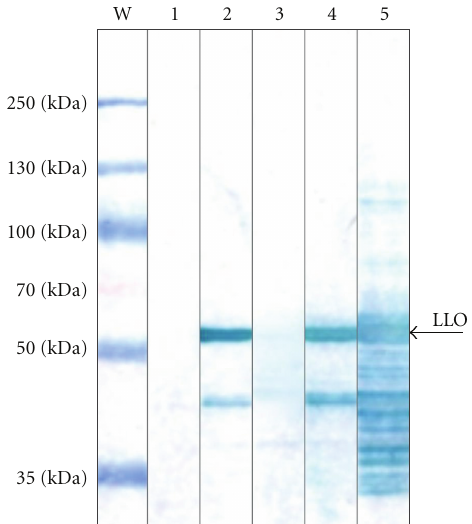
Figure 2: Western blot analysis of B. subtilis supernatants. Results of Western blot analysis of Bacillus subtilis supernatants with anti-LLO polyclonal antibody. 1: control wild-type strain MB4 supernatant , 2: BR1/S + IPTG, 3: BR1/S without IPTG, 4: BR1/89 + IPTG, 5: BR1/90 + IPTG. W: molecular weight marker. The LLO location is